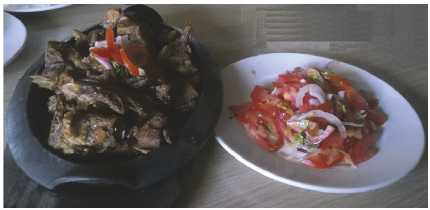
Figure 1: Kachumbari salad served alongside roast